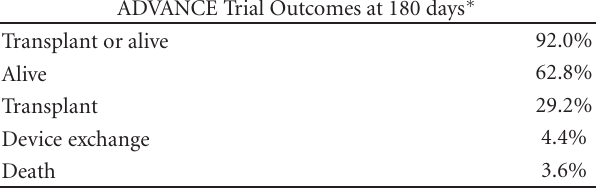
Table 1: Survival after HVAD Implantation: Evaluation of Heart- Ware HVAD left ventricular assist device for the treatment of advanced heart failure: Results of the ADVANCE Bridge to trans- plant Trial.